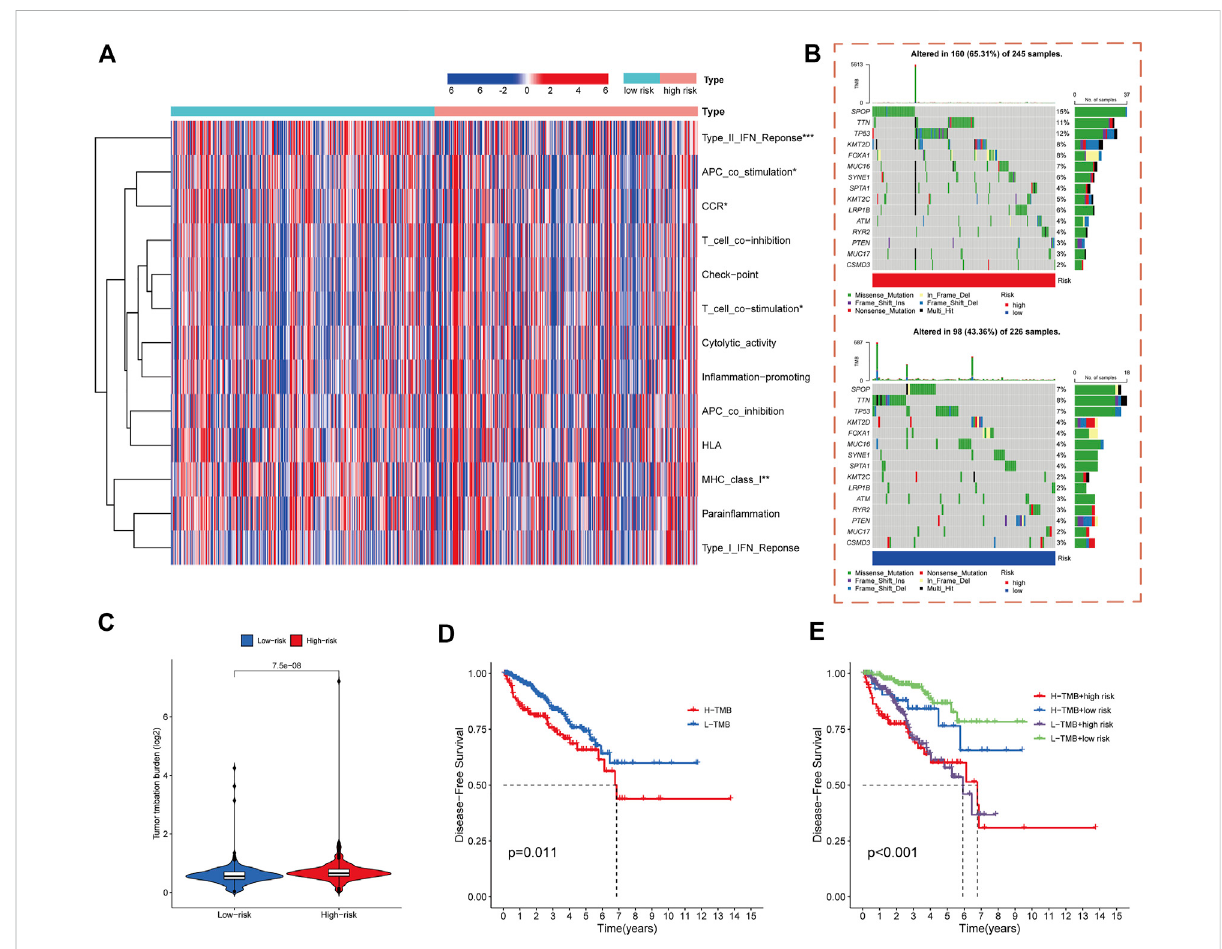
FIGURE 6 Immune functional and mutation landscape analysis of high- and low-risk cohorts. (A) Heatmap of immune function expression in high- and low-risk cohorts. (B) Waterfall plot of mutation rates in high- and low-risk cohorts. (C) TMB levels in high- and low-risk cohorts. (D) Kaplan-Meier analysis of DFS rates in high- and low-TMB cohorts. (E) Kaplan-Meier analysis of DFS rates in different TMB and risk score